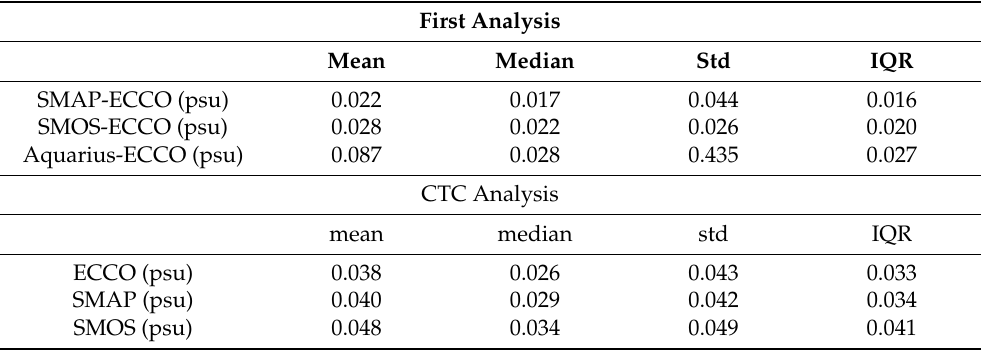
Table 1. Table summarizing the statistics of the methods to quantify each product’s sampling error and standard deviation of the error, presented in this paper. The statistics here are for the weekly time scales for Aquarius, SMAP and SMOS. The CTC method was not applied on Aquarius as the method needs to be applied on datasets resolving the same spatial